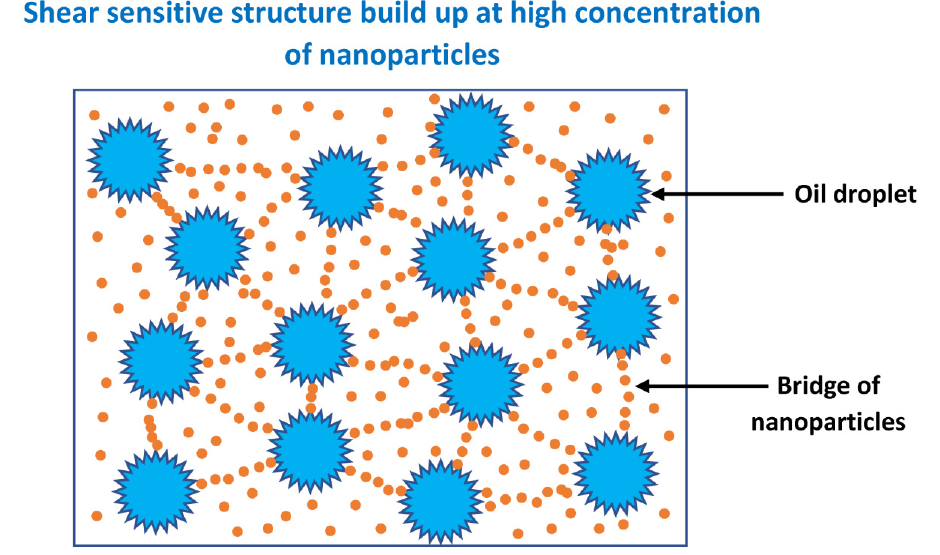
Figure 12. Shear-sensitive structure build-up in emulsions at high nanoparticle concentrations.